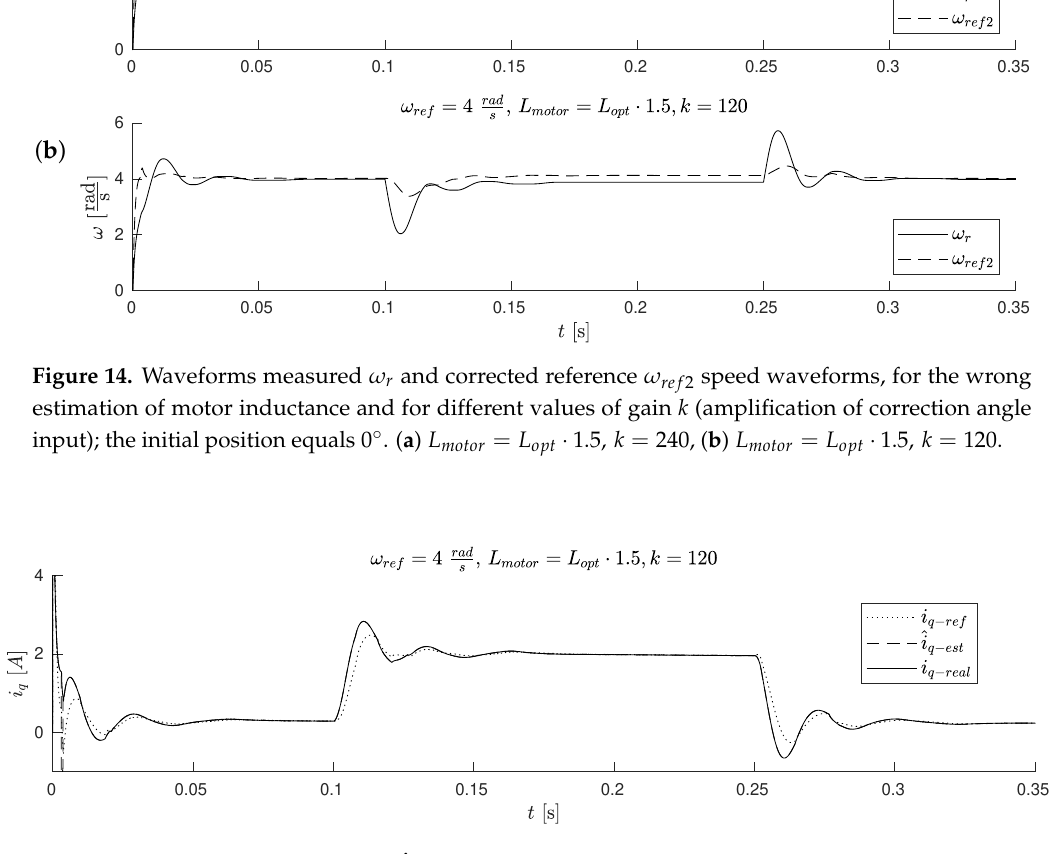
real current waveforms; wrong estimation −